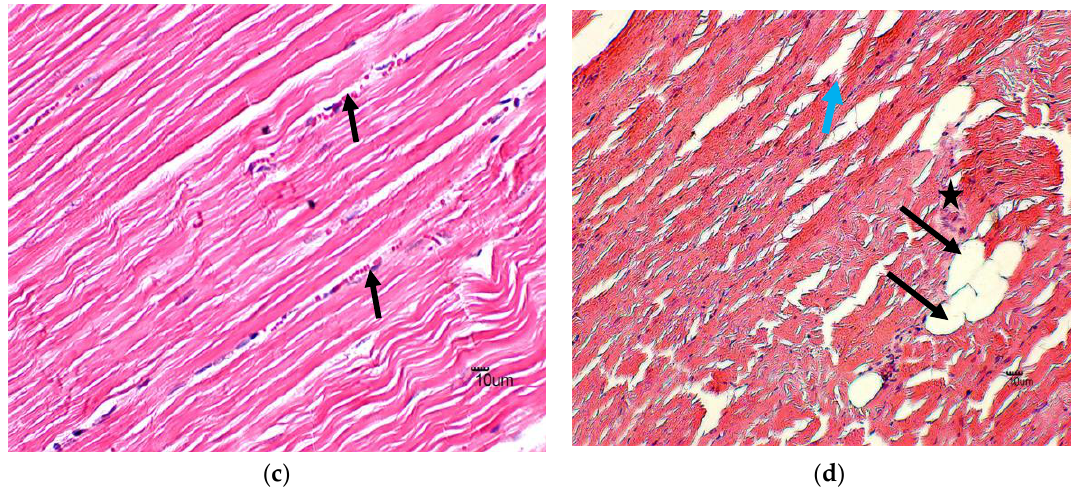
Figure 1. Histological analysis on longissimus thoracis et lumborum muscle of goats supplemented with naturally produced lovastatin ( a ) A photomicrograph of longitudinal section of muscle from control (0 mg / kg BW) group showing normal morphological architecture of the skeletal muscles, with myofibril and myocyte nuclei located peripherally on the myofibril filaments with myofibril separated by interstitial space and the striated character of normal muscular structure (double-ended arrow) (H&E × 400). ( b ) A photomicrograph of longitudinal section of muscle (2 mg lovastatin / kg LW) showing mild hemorrhages within the interstitial space (arrow) and striated character of normal muscle structure (double-ended arrow) (H&E × 400). ( c ) Photomicrograph of muscle (4 mg lovastatin / kg LW) showing mild hemorrhages within the interstitial space with normal morphology myofilament (H&E × 400) ( d ) Photomicrograph of muscle (6 mg lovastatin / kg LW) showing marked myofibrillar degeneration (star), cellular infiltration associated with myofibril rupture (blue arrow) and vacuolization of myocytes and interstitial space (arrow) (H&E × 400). Table 2. Histology scores of longissimus thoracis et lumborum muscle of goats supplemented with naturally produced lovastatin.